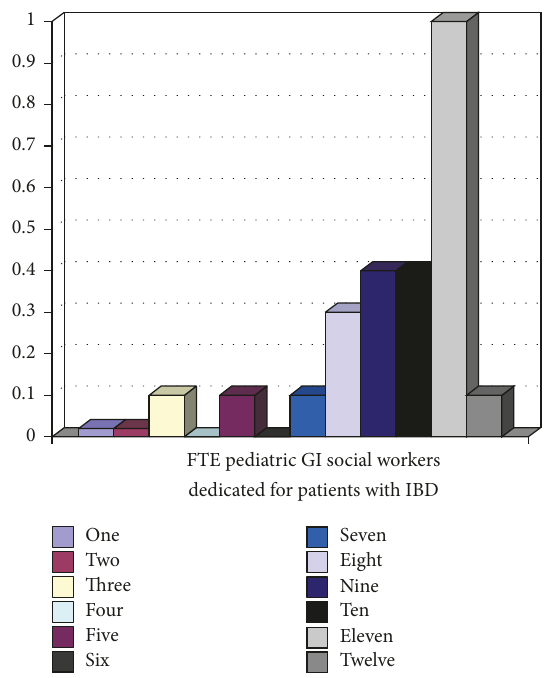
Figure 4: Full-time equivalent (FTE) social workers for children with IBD per centre.